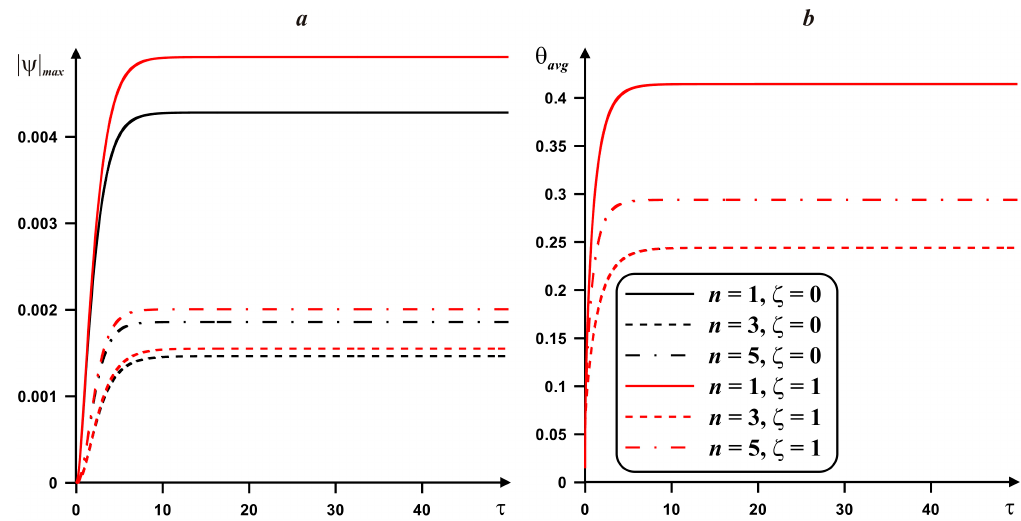
Figure 7. Variations of fluid flow rate and average heater temperature for h 1 = 0.15 and different magnitudes of ζ and n : ( a ) fluid flow rate; ( b ) average heater temperature.